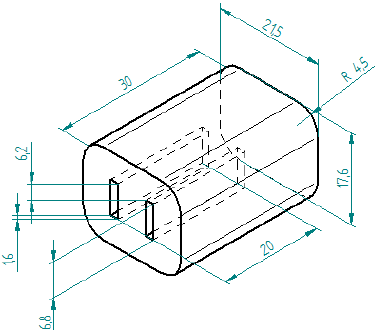
Figure 3. Drawing of the socket to model in the tests of the PERSEL-based UX redesign process (dimensions are in millimeters).